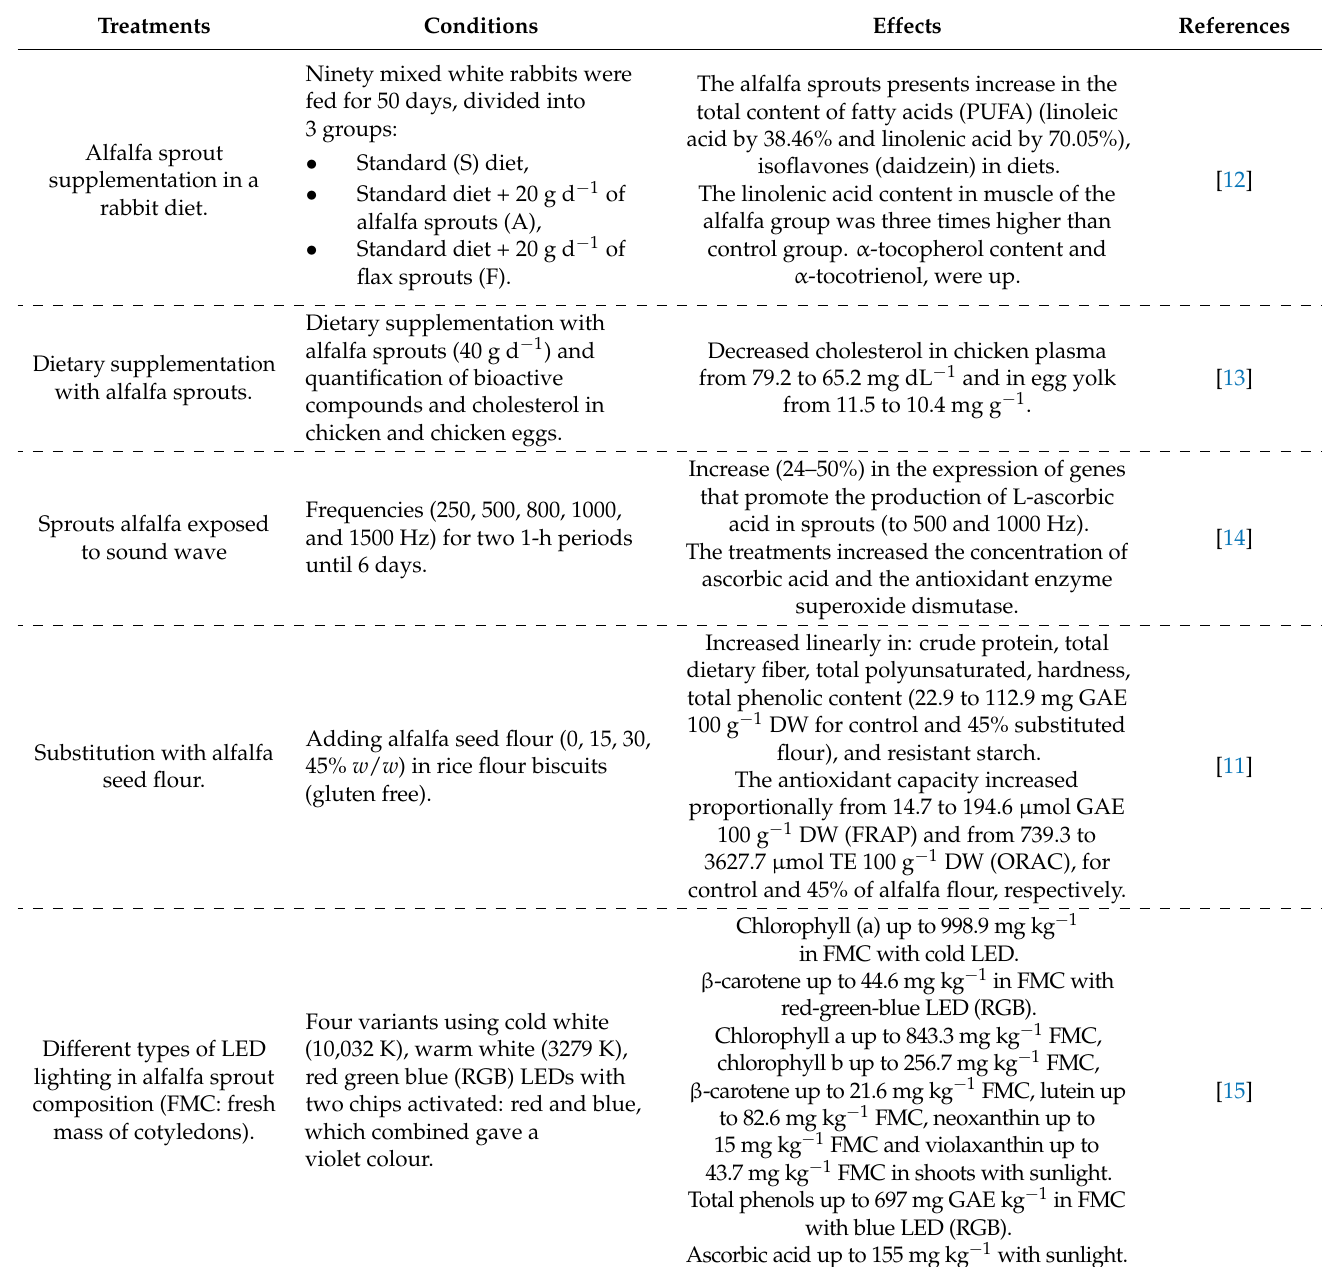
Table 2. Modification of the composition and/or bioactivity determined in alfalfa ( Medicago sativa L.) because of different